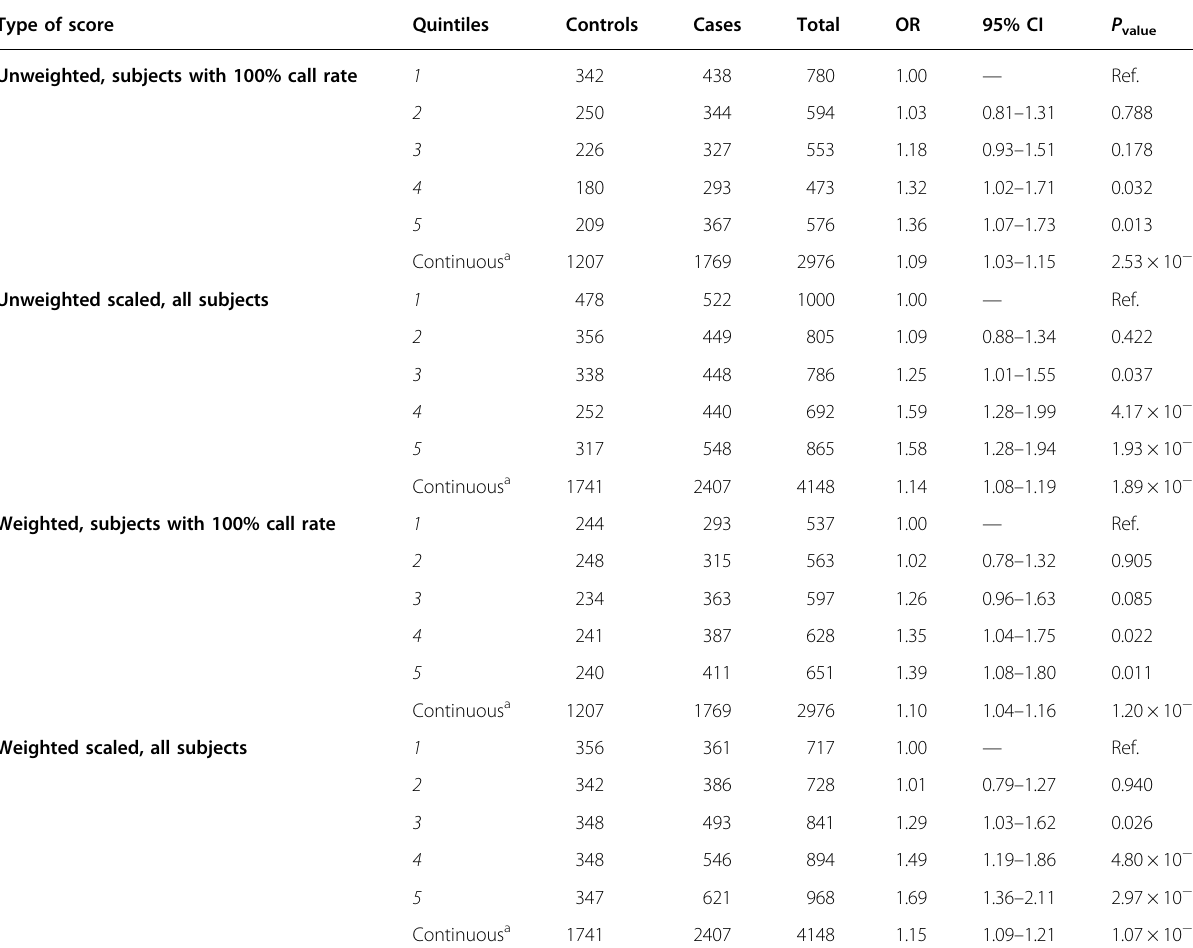
Table 3 Association between teloscore and MM